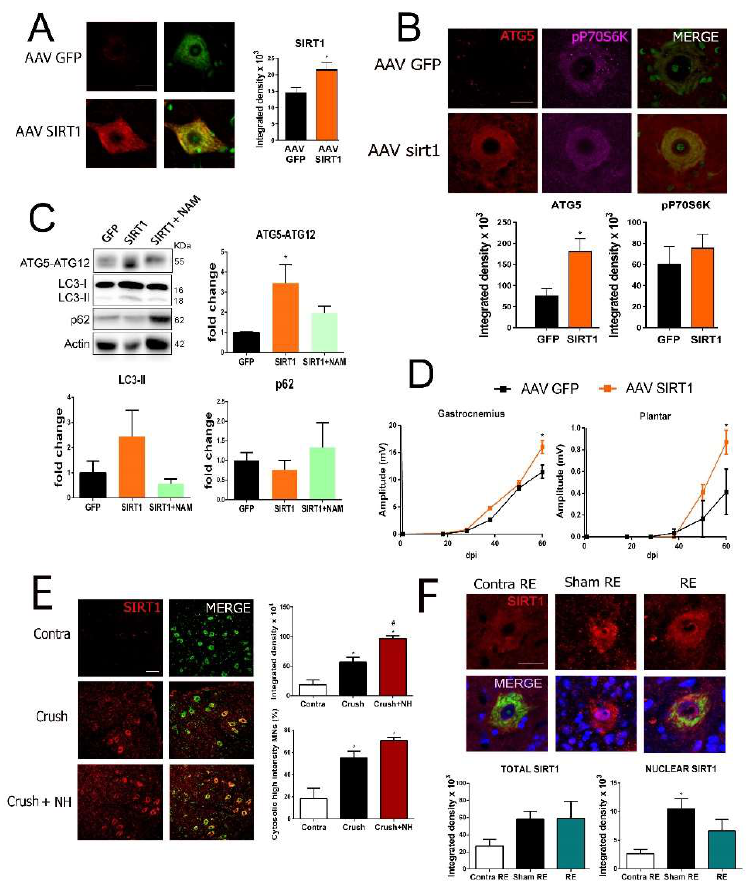
Figure 3. NAD + -dependent deacetylase sirtuin-1 (SIRT1) promotes autophagy in MNs and is cytosolic during motor axon regeneration. ( A ) Representative confocal images of SIRT1 (red) counterstained with FluoroNissl (green) in MNs from the AAVrh10-GFP or AAVrh10-SIRT1 after axotomy at 60 dpi Scale bar = 20 µ m. ( B ) Representative confocal images of MNs stained with ATG5 and p-p70S6K at T-389 with FluoroNissl green from the di ff erent groups and associated bar graphs of the mean ( ± SEM) intensity for each marker inside the cytoplasm of injured MNs at 7 dpi (n = 4 animals per group, t -test, * p < 0.05 vs. AAV-GFP) Scale bar = 20 µ m. ( C ) Western blot and corresponding bar graphs of the quantification of di ff erent proteins related to autophagy (ATG5, LC3-II, and p62) in the spinal cord from axotomy-injured animals injected with AAVrh10-GFP or AAVrh10-SIRT1 with or without oral nicotinamide (NAM). (n = 4, ANOVA, post hoc Bonferroni, * p < 0.05 vs. AAV-GFP). ( D ) Mean amplitudes ( ± SEM) values of CMAP recordings obtained during follow-up post-axotomy from the gastrocnemius (GA) and plantar muscles in animals overexpressing GFP or SIRT1 (n = 4–6, ANOVA, post hoc Bonferroni, * p < 0.05 vs. AAV-GFP ( E ) Up , Confocal images of MNs immunolabeled for SIRT1 in red and counterstained with FluoroNissl (green) and DAPI (blue) from MNs of Contra, crush, and NH-treated animals at 35 dpi. Scale bar = 50 µ m. Down , Histograms of the mean of the SIRT1 immunofluorescence intensity inside the cytoplasm of injured MNs (n = 3 animals per group, ANOVA, post hoc Bonferroni, * p < 0.05 vs. contra and # p < 0.05 vs. Crush). ( F ) Top , Confocal microphotographs and graphs showing levels of SIRT1 (red) co-labeled with FluoroNissl (green) from contralateral site (Contra RE), sham (Sham RE), and after peripheral nerve root avulsion with reimplant (RE). Scale bar = 25 µ m. Bottom , Graph of the means of the immunofluorescence intensity inside MNs or inside the nuclei of MNs (n = 3–4 per group, ANOVA, post hoc Bonferroni, * p < 0.05 vs. Contra RE, # p < 0.05 vs. Sham